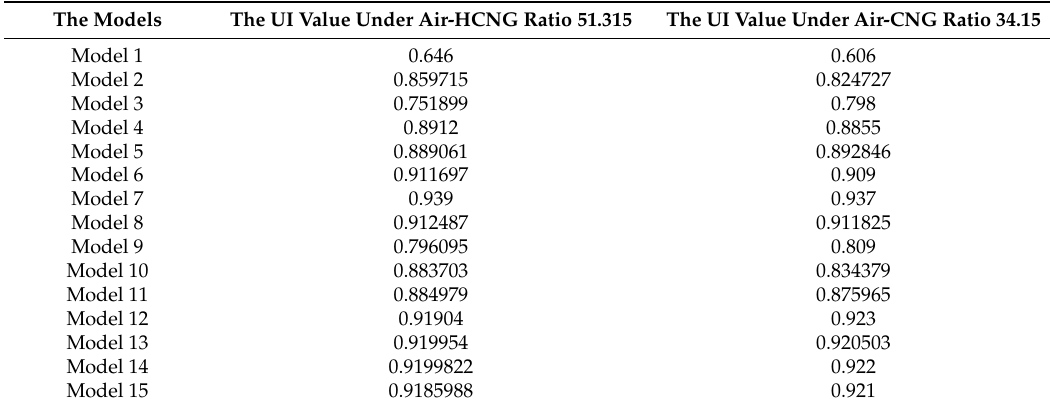
Table 6. The value of uniformity index according to the simulation results for new mixer